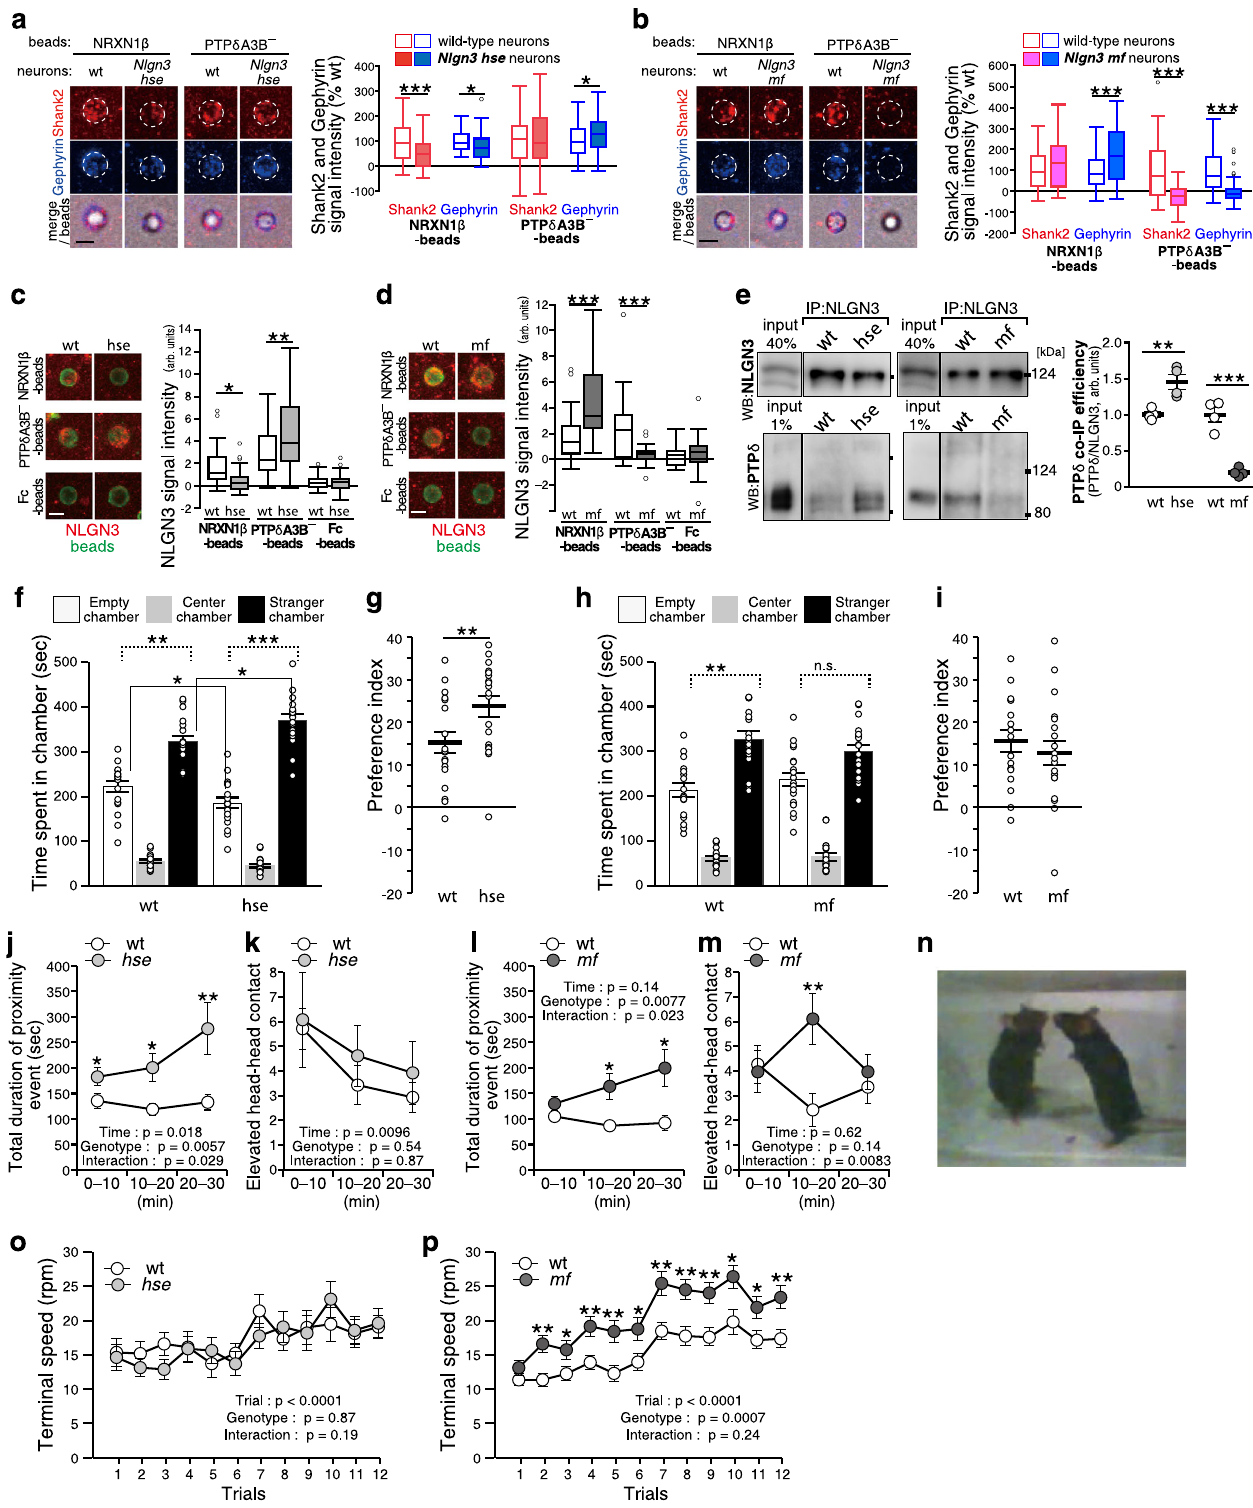
selectively upregulated, while those of the excitatory synaptic proteins vesicular glutamate transporter 1 (VGluT1) and PSD95 remained unaltered (Fig. 6d). Consistently, immunostaining signal ratios for VGAT compared to VGluT1 in the cerebral cortex were higher in the Nlgn3 mf mutants than littermate controls (Supplementary Fig. 7j, k). On the contrary, the frequencies of both miniature excitatory and